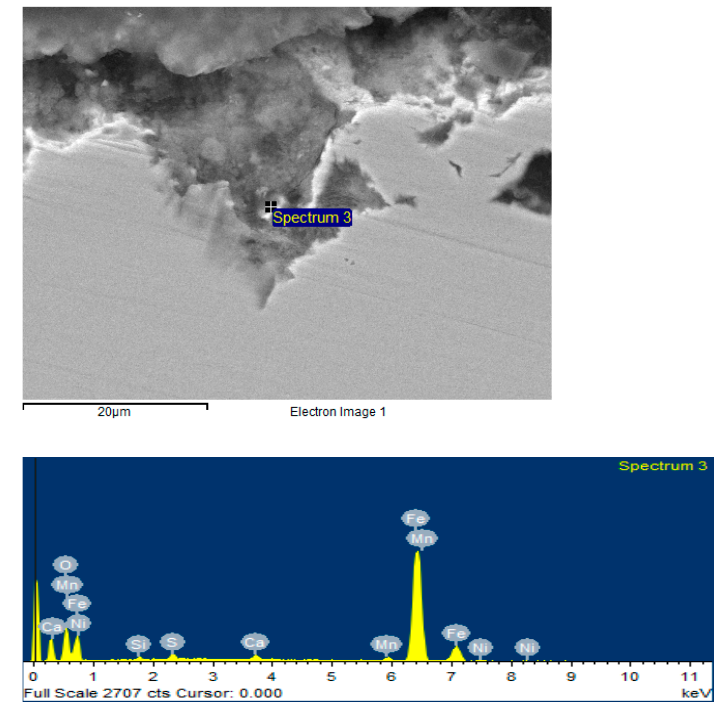
Figure 7. Surface image and elemental composition for the sample (test speed 50 rpm) obtained with